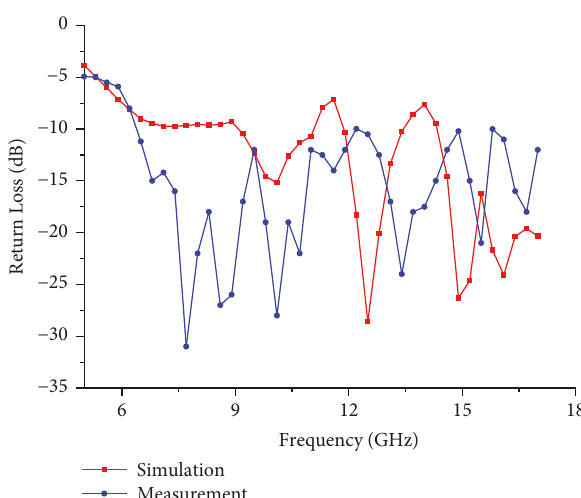
Figure 14: Comparison of return loss between measurement and simulation.